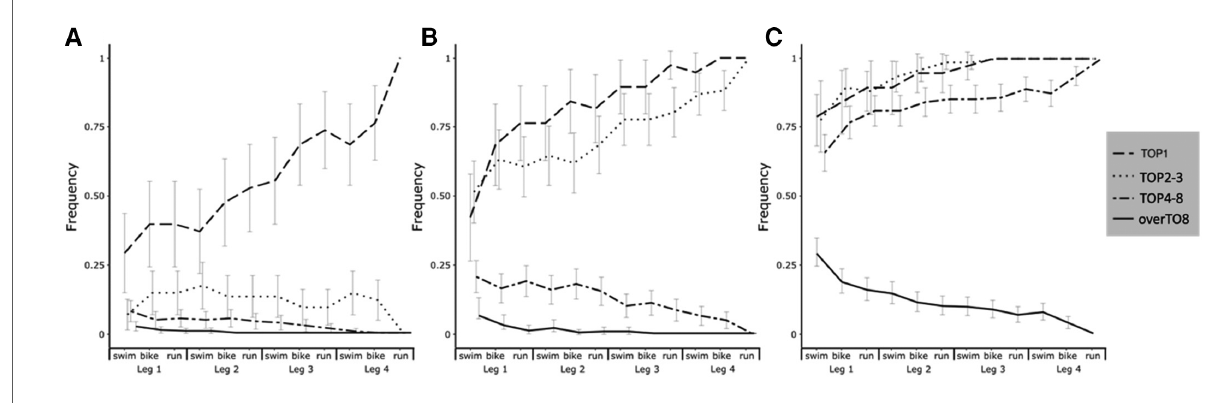
FIGURE 1 Frequency of reaching a Winner ( A ), Medalist ( B ), or Finalist ( C ) state depending on the state obtained during the